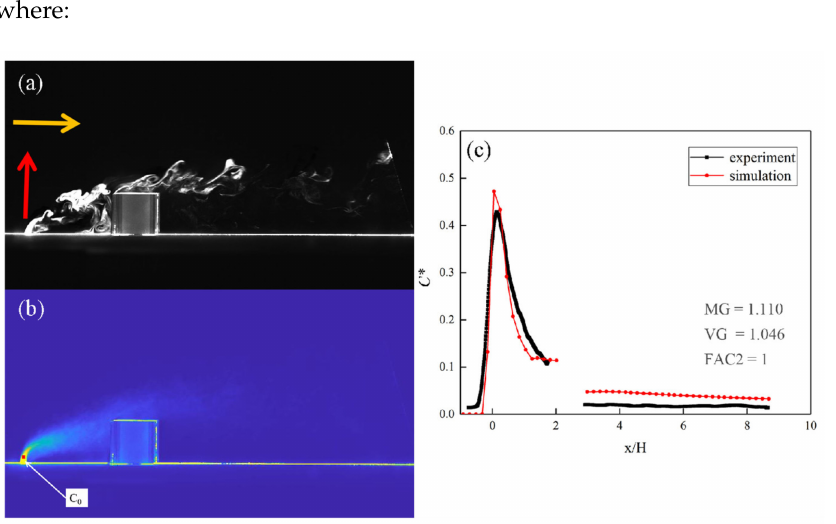
Figure 3. ( a ) Grayscale picture of instantaneous concentration field, ( b ) grayscale picture of average concentration field, ( c ) comparison of numerical simulations and experimental